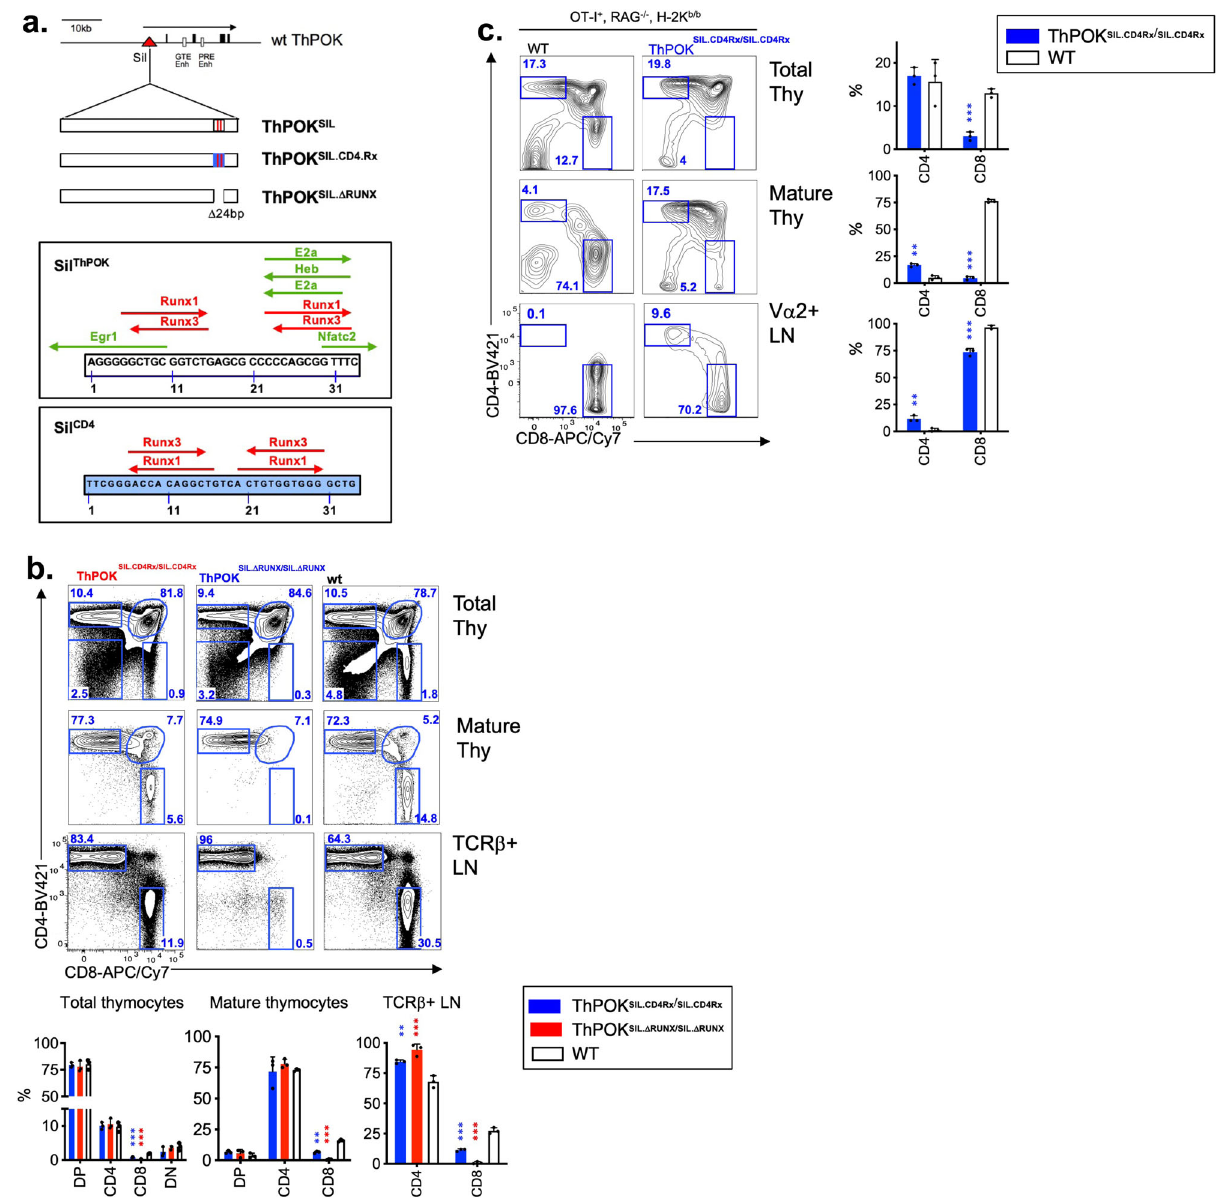
Fig. 6 Region of Sil ThPOK surrounding conserved Runx consensus sites is critical for its proper regulation. a Schematic of ThPOK SIL.CD4.Rx and ThPOK SIL. Δ RUNX knock-in alleles, indicating the location of conserved Runx sites (red bars). Blue color indicates swapped region from the Sil CD4 . Bottom panels show the position/orientation of indicated TF consensus sites for the swapped regions. Note that the occurrence of Ebox consensus motifs at indicated positions within the Sil ThPOK but not Sil CD4 . b FACS analysis of CD4, and CD8 expression of total thymocytes, or indicated gated thymocyte and peripheral T-cell subsets of wt, CD4 SIL.CD4Rx/SIL.CD4Rx and CD4 SIL. Δ RUNX/SIL. Δ RUNX mice. Results are representative of multiple experiments. N = 3 independent animals per strain. Plots showing % of DP, SP CD4, SP CD8, and DN thymocytes for mice of indicated genotypes are shown at right. N = 3 independent animals per strain. Data are presented as mean values + / − SEM. A P value < 0.05 was considered signi fi cant. c FACS analysis of CD4 and CD8 expression by indicated thymic or peripheral lymphocyte populations of wt or CD4 SIL.CD4Rx/SIL.CD4Rx mice expressing the MHC class I-restricted OT- 1 TCR transgene on the selecting H-2b/b background. Results are representative of multiple experiments. Note that the proportion of SP CD4 mature thymocytes is strongly or moderately increased for mature thymocytes a or gated peripheral T cells, respectively, from CD4 SIL.CD4Rx/SIL.CD4Rx mice. N = 3 independent animals per strain. Statistical signi fi cance was determined between indicated mutant mice and ThPOK + / + mice by one-way ANOVA with post hoc Tukey HSD, and indicated by asterisks (* P < 0.01; ** P < 0.005; *** P < 0.001). Statistical signi fi cance was calculated for each indicated mutant line relative to wt